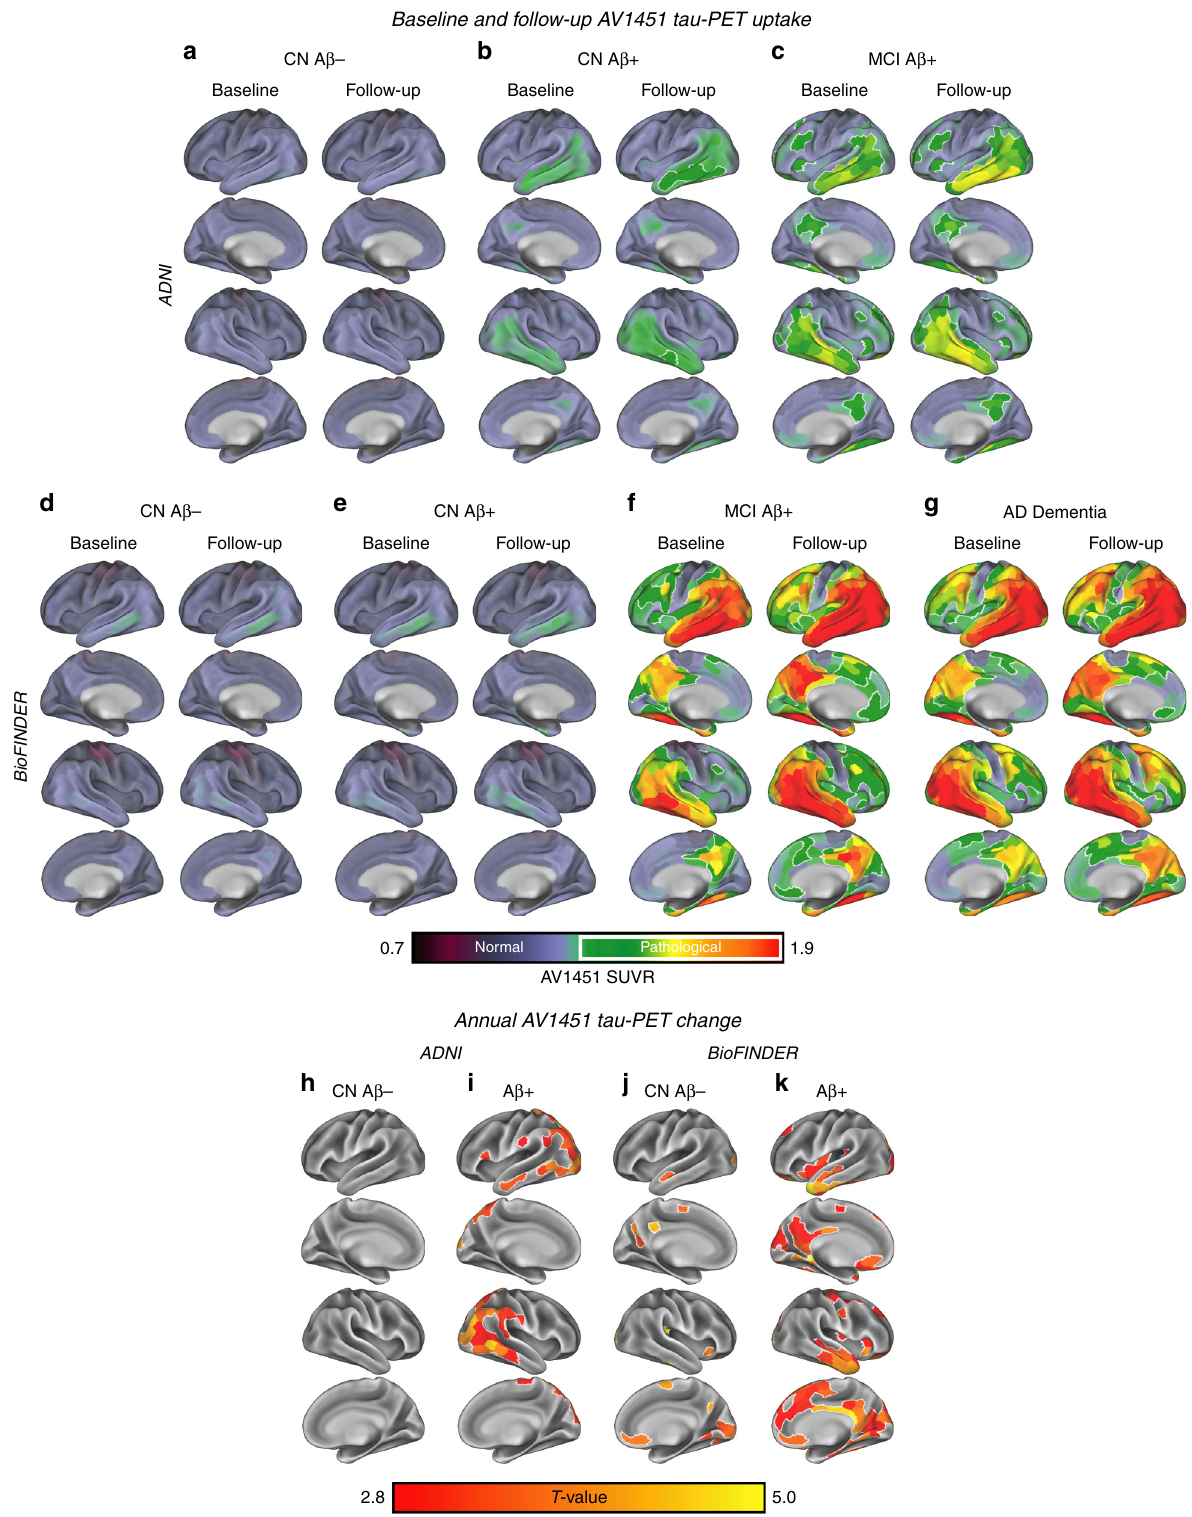
Fig. 1 Group-average tau-PET levels. Group-average tau-PET levels for the ADNI ( a – c ) and BioFINDER ( d – e ) samples, strati fi ed by diagnostic group. Tau-PET levels are showed as continuous values, where pathological tau-PET levels (i.e., surpassing an SUVR of 1.3) 26 are highlighted by white outlines in Panels a – g . Group-average data are shown in ADNI for 28 CN A β − ( a ), 32 CN A β + ( b ) and 21 MCI A β + ( c ) at baseline and follow-up. For BioFINDER, group-average data are shown for 16 CN A β − ( d ), 16 CN A β + ( e ), 7 MCI A β + ( f ) and 18 AD Dementia patients ( g ). In ADNI, ROI-wise t -tests against zero show no signi fi cant annual tau-PET increases in 28 CN A β − ( h ), but signi fi cant ( p <0.005) temporo-parietal tau-PET changes in 53A β + ( i ). In BioFINDER, t -tests against zero show minor annual tau-PET increases in the 16 CN A β − ( j ), but widespread temporal, parietal and frontal tau-PET increases in the 41A β + subjects ( k